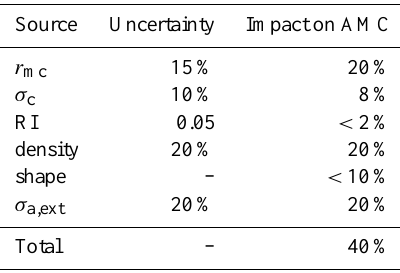
Table 2. Uncertainty sources and relative impact on AMC estima- tion. The extinction uncertainty contains both instrumental (overlap, noise, etc.) and inversion method (lidar ratio, reference altitude) er- rors. The total error on AMC is calculated in case of independent error